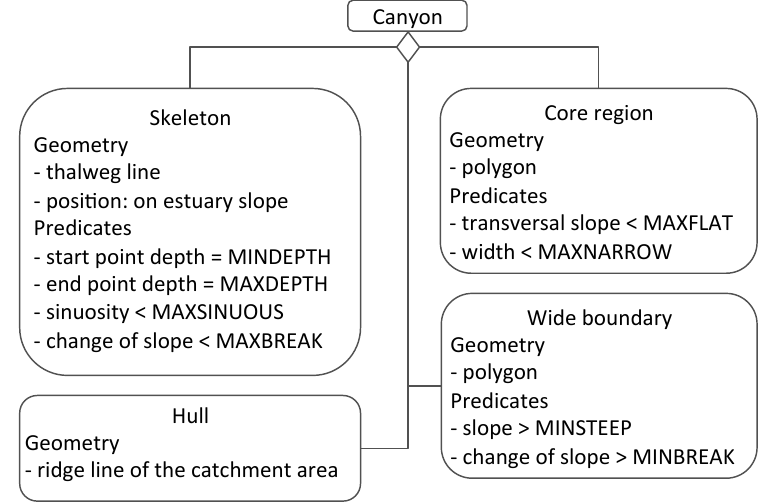
Figure 3. The submarine canyon concept with its geometrical attributes and